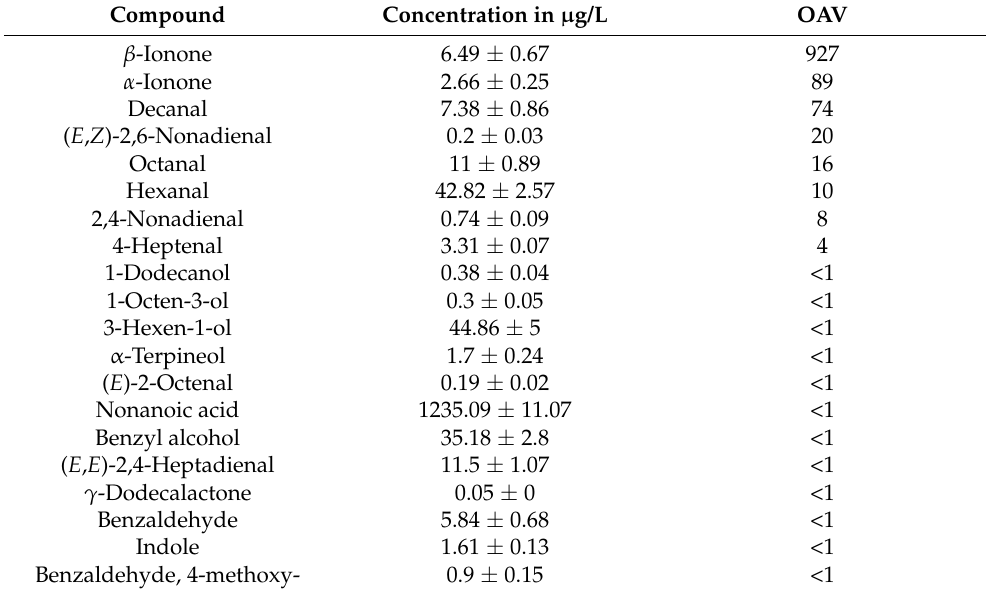
Table A12. Results of semi-quantification and calculated OAVs for sample 147.